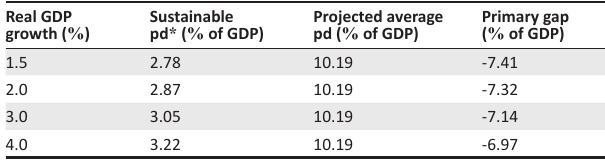
FIGURE 5: Sustainable versus actual primary balance. TABLE 1: Primary deficit to keep debt below 25 % of GDP by